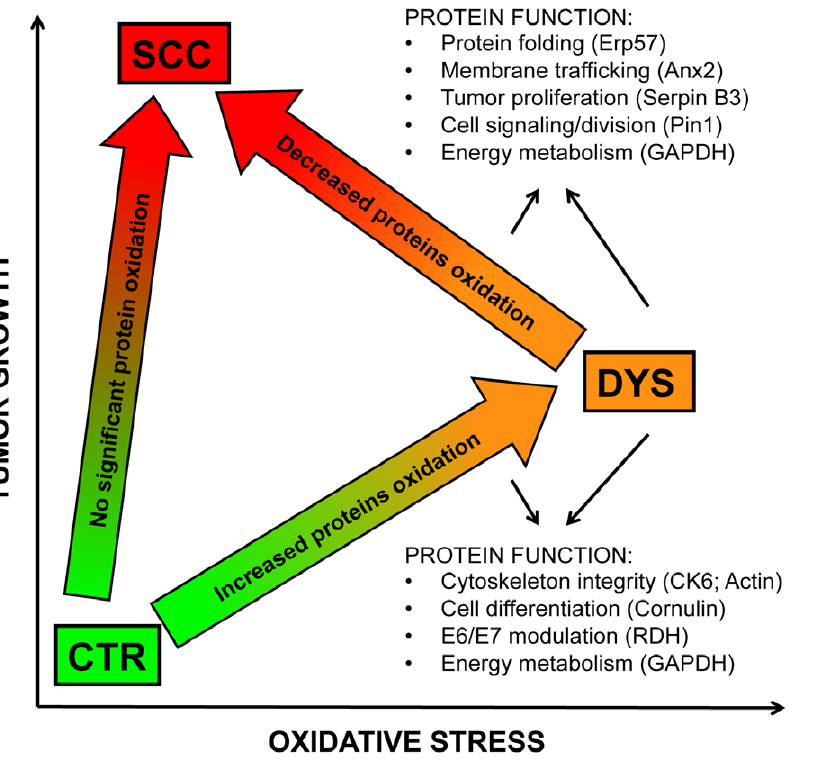
Figure 6. Proposed scenario of putative interplay between oxidative stress and tumor development. Function of the proteins showing altered oxidation in both DYS and SCC are listed. DYS is characterized by an increased oxidative environment, compared with both control and SCC tissues.